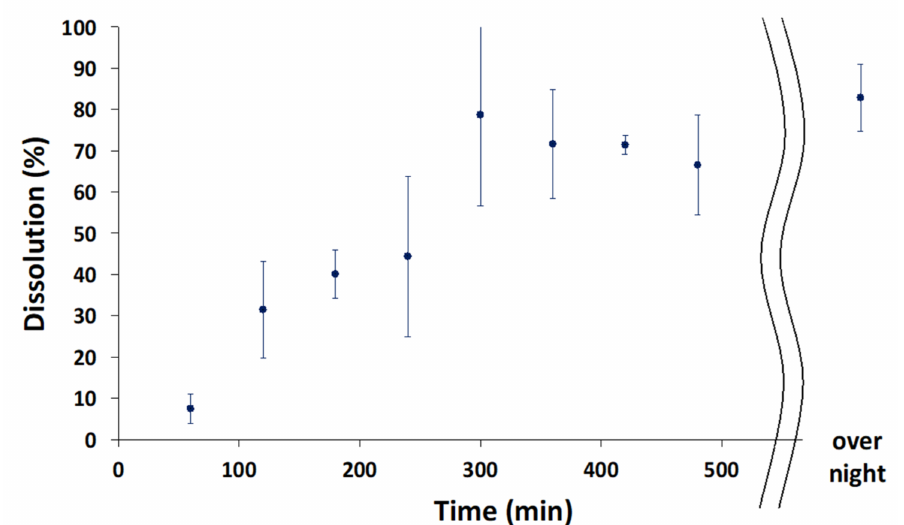
Figure 7. Drug dissolution profiles. The data show the means ± SD ( n =